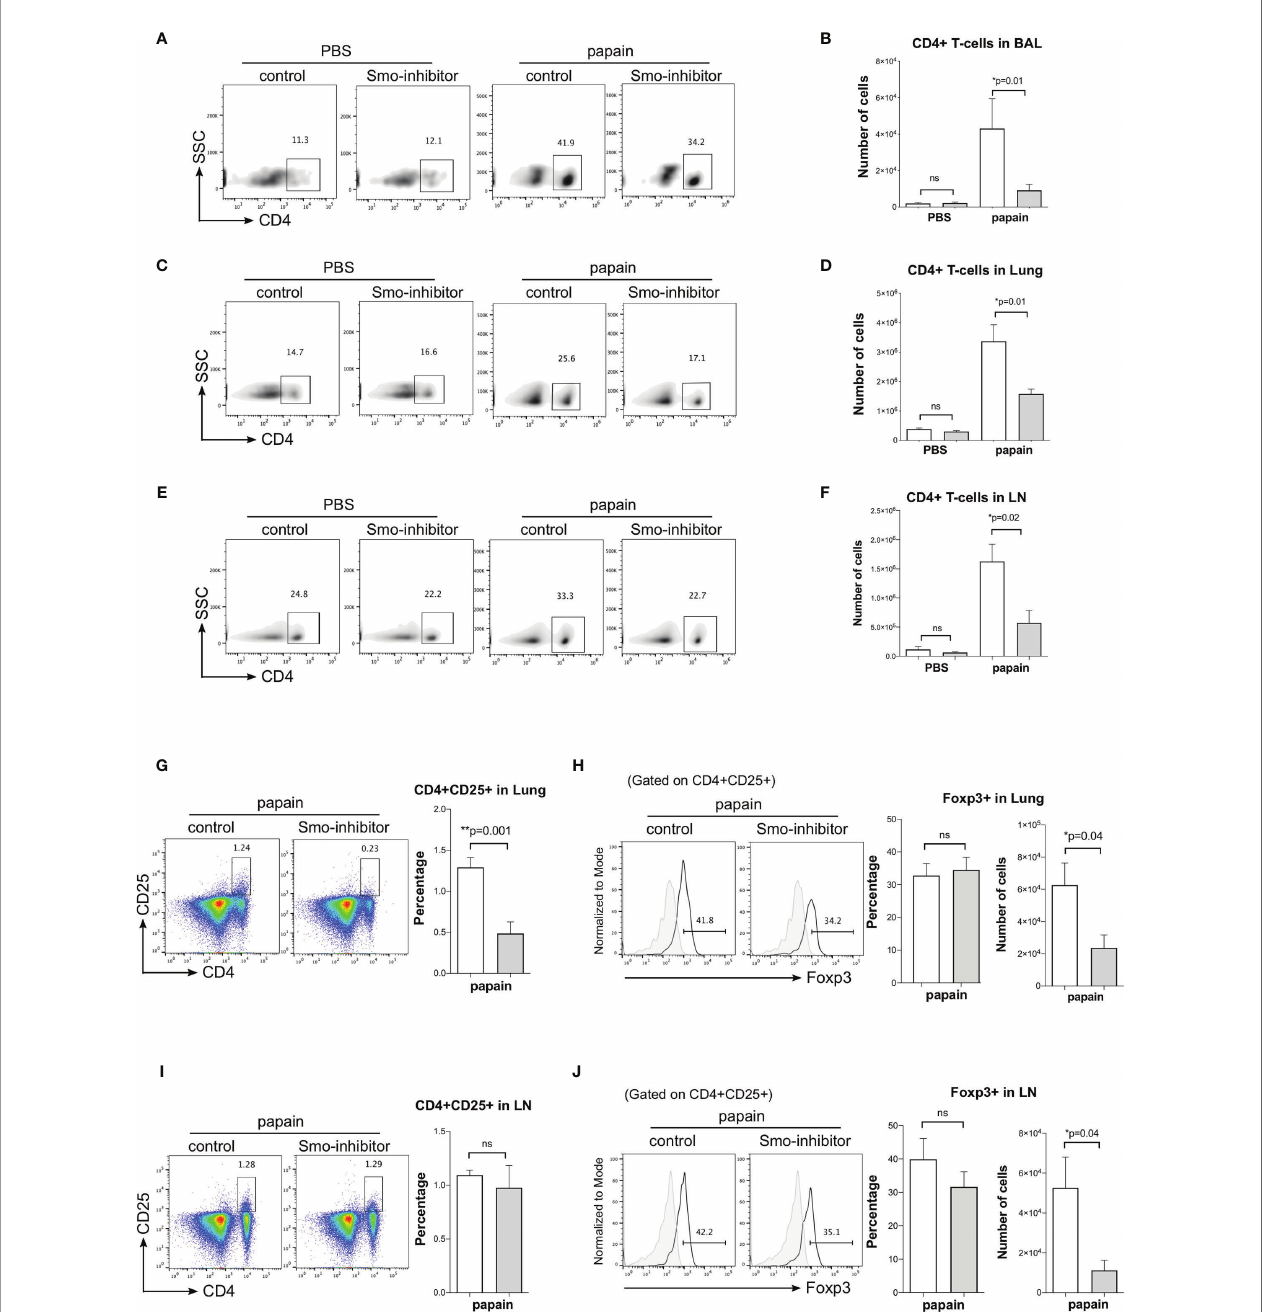
FIGURE 3 | Administration of Smo inhibitor decreases CD4+ T-cells upon papain challenge. Mice underwent the PBS or papain protocol and Smoothened inhibitor or control treatment as in Figure 1A . (A – F) Facs analysis of CD4+ T-cells under different treatments. Density plots: anti-CD4 staining of cells from (A) BAL (C) lung, and (D) mLN, giving percentage of cells in the region. Bar charts: mean ± SEM number of CD4+ T-cells in (B) BAL, (D) lung, and (F) mLN from PBS and papain- protocol mice treated with Smo inhibitor and control. (G – J) Facs analysis of Treg populations in lung and mLN. (G) Representative Facs plots show anti-CD4 and anti-CD25 staining in lung under papain conditions. Bar chart: mean ± SEM percentage of CD4+CD25+ T-cells under papain conditions. (H) Histograms show intracellular expression of Foxp3 in CD4+CD25+ lung cells in the papain group. Bar charts: mean ± SEM (left) percentage and (right) number of Foxp3+CD4+CD25+ in lung cells under papain treatment. (I) Facs plots show anti-CD4 and anti-CD25 staining in mLN under papain conditions. Bar chart: mean ± SEM percentage of CD4+CD25+ under papain conditions. (J) Histograms show intracellular expression of Foxp3 in CD4+CD25+ lung cells in the papain group. Bar charts: mean ± SEM (left) percentage and (right) number of Foxp3+CD4+CD25+ in mLN under papain treatment. Gray histograms show staining with an isotype control antibody. PBS groups and papain-Smo inhibitor n = 5; papain-control group n = 6; *p < 0.05, **p < 0.01 unpaired Student ’ s t-test. Data shown are from a representative experiment, and n numbers represent individual mice in the experiment shown. n.s., not signi fi